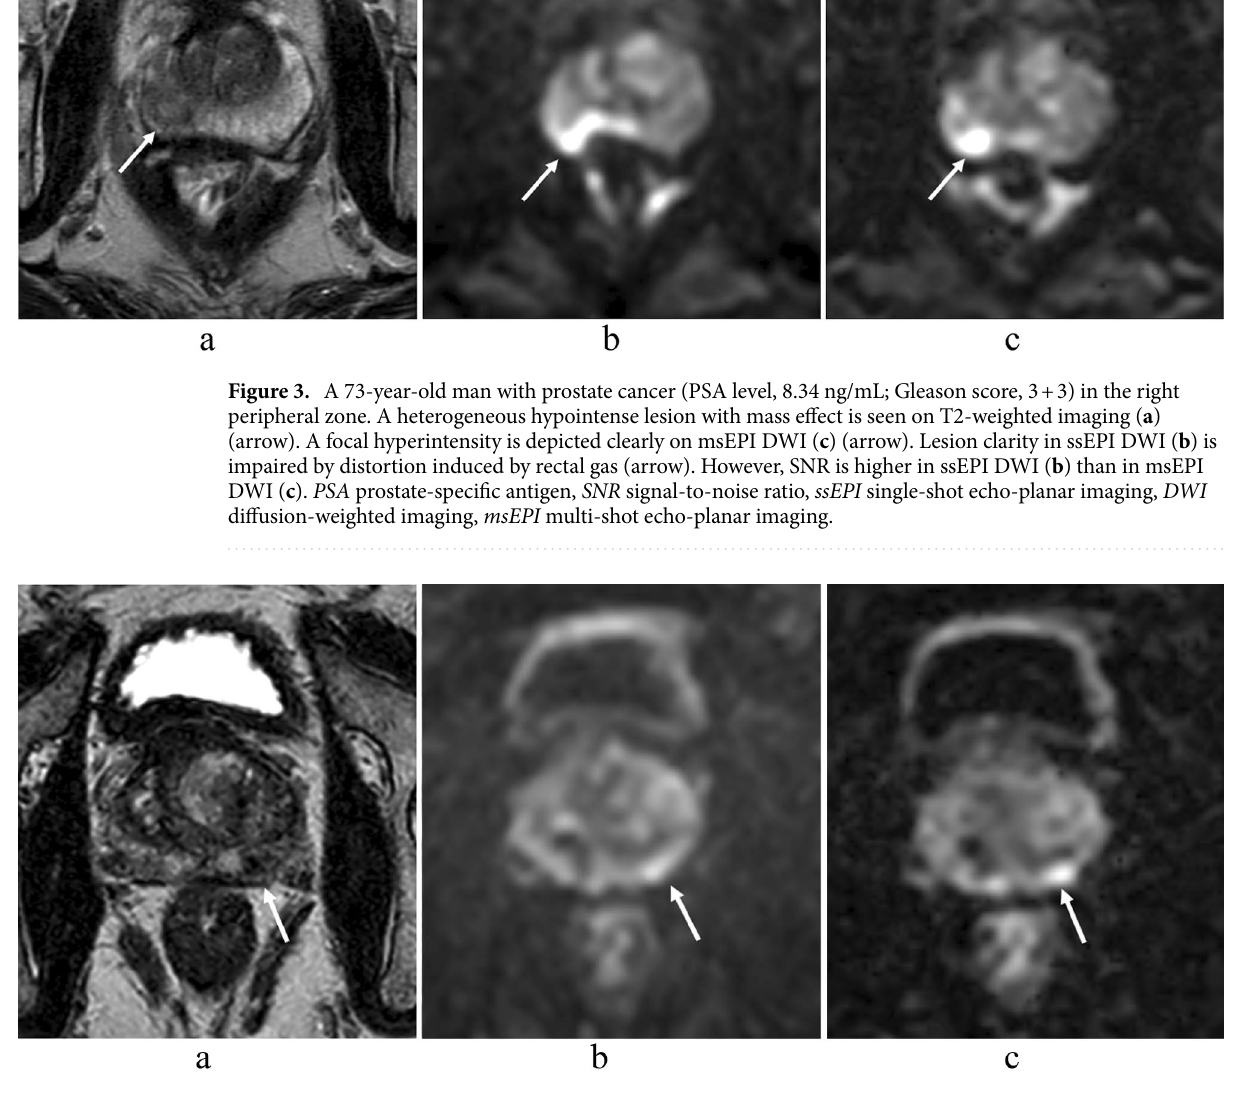
Figure 4. A 58-year-old man with prostate cancer (PSA level, 9.43 ng/mL; Gleason score, 4 + 3) in the left peripheral zone. A homogeneous hypointense lesion is seen on T2-weighted imaging ( a ) (arrow). A focal hyperintensity is depicted clearly on msEPI DWI ( c ) (arrow). Lesion conspicuity is lower in ssEPI DWI ( b ) than in msEPI DWI ( c ) (arrow). PSA prostate-specific antigen, msEPI multi-shot echo-planar imaging, DWI diffusion-weighted imaging, ssEPI single-shot echo-planar